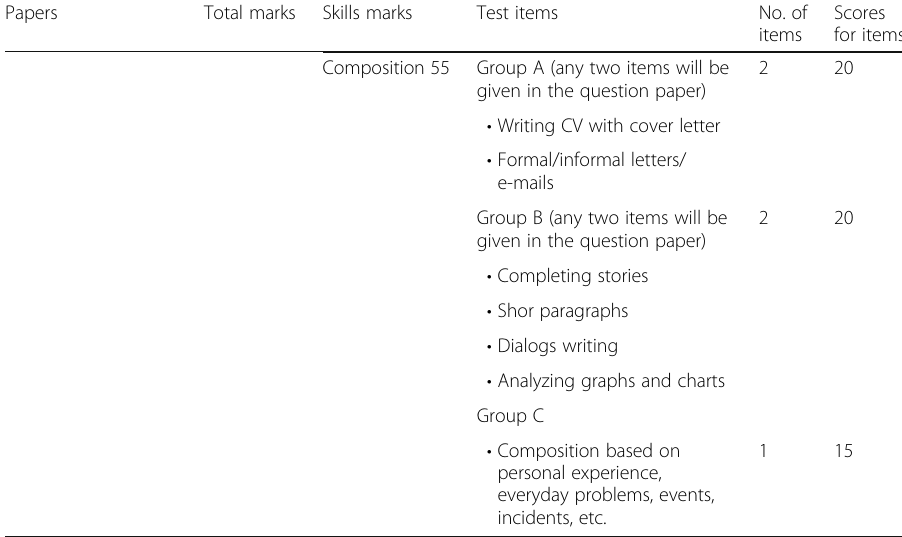
Table 1 Mark distribution and structure of SSC English examination (Continued)